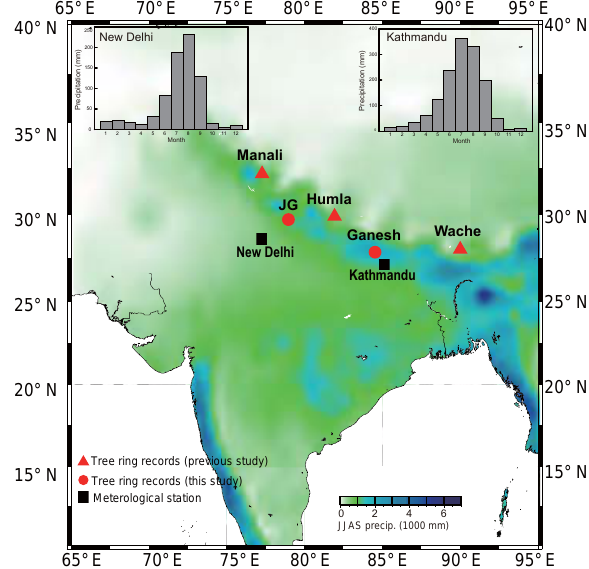
Figure 1. Map of the subcontinent showing tree-ring sites and color-coded climatological monsoon precipitation from June to September. Insets show climatology of monthly precipitation in Kathmandu and New